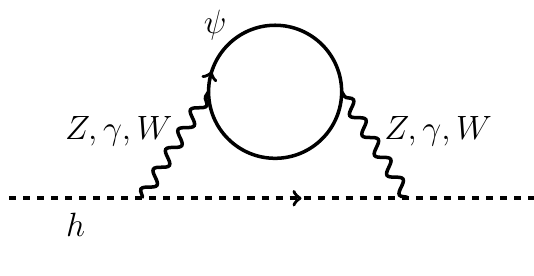
Figure 11 . Two-loop correction to the Higgs boson mass-squared parameter proportional to the mass squared of any heavy (cid:12)eld